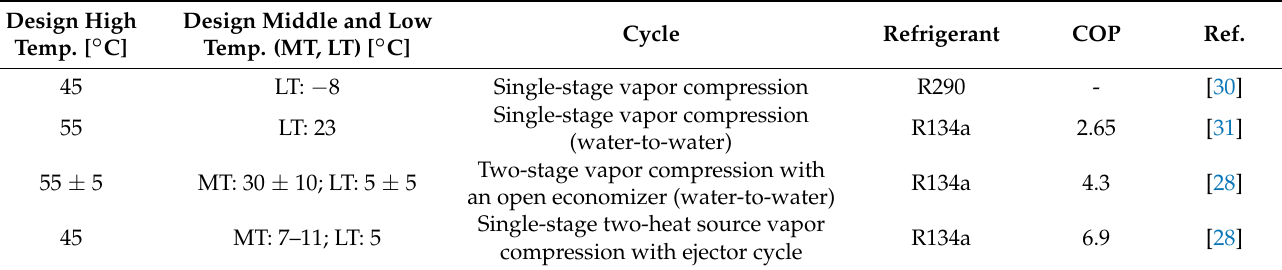
Table 1. Summary of HP technologies applicable to the WavoWater.